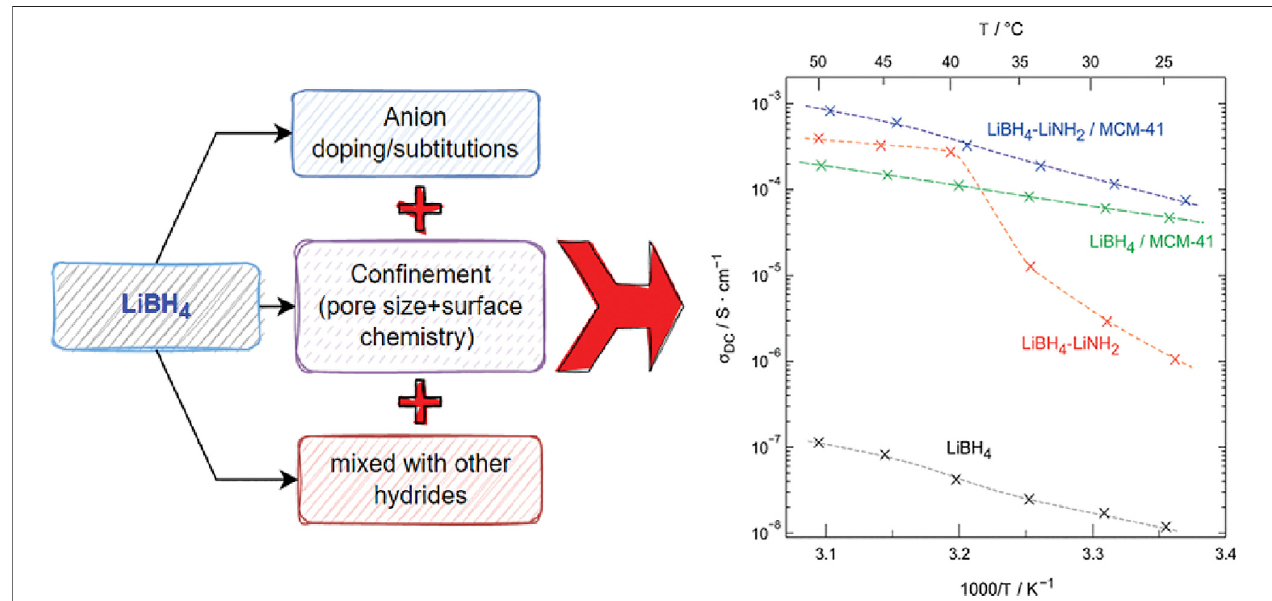
FIGURE 2 | Summary of various strategies for designing enhanced Li + conductivity in LiBH 4 and the Li + conductivity plot from the previously reported study. The conductivity plot is taken from the study of Zettl et al. (2020).